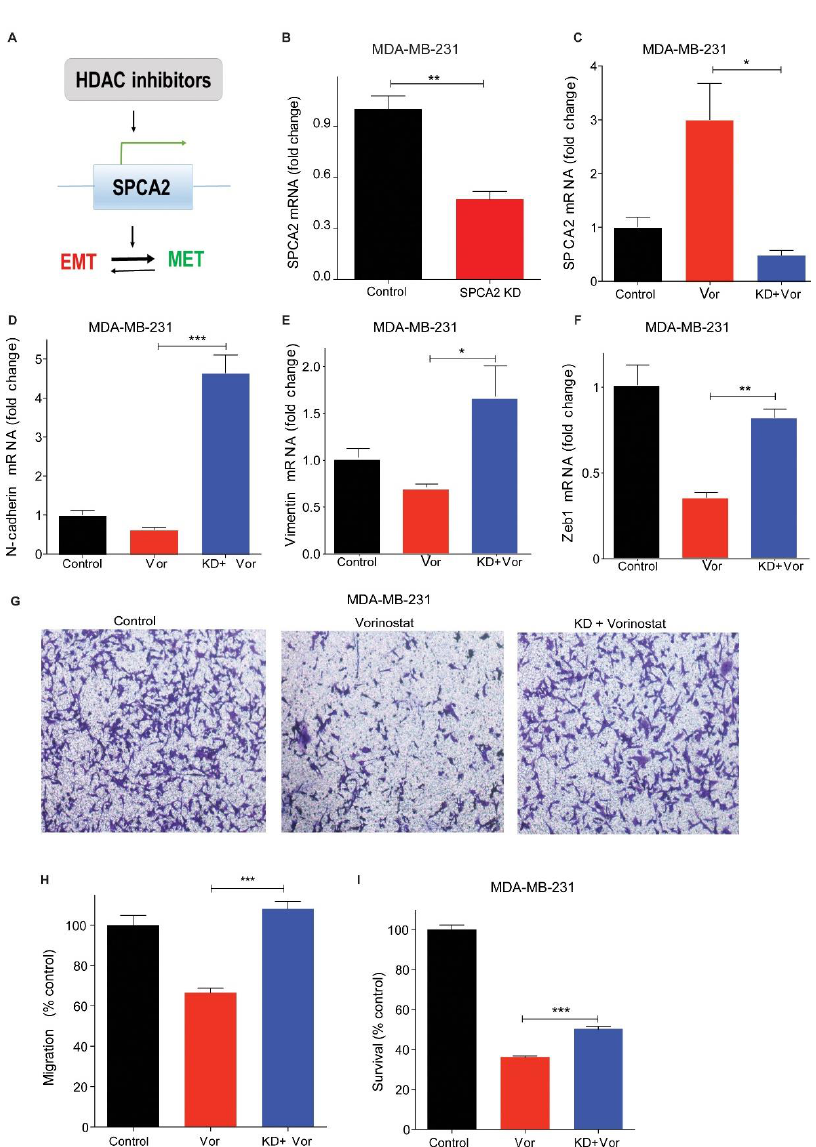
Figure 4. SPCA2 is required for HDACi-induced MET changes in TNBC cell lines. ( A ) Schematic showing that HDAC inhibitors regulate SPCA2 expression, which in turn, promotes MET. ( B ) SPCA2 mRNA, determined by qPCR, shows efficacy of knockdown (KD) in MDA-MB-231 cells relative to scramble shRNA control, and ( C ) following treatment with vehicle (control) or vorinostat (2.5 µM) for 24 h, as indicated. ( D – F ) Expression of mesenchymal gene markers N-cadherin, vimentin and ZEB1 was determined by qPCR following treatment with vehicle (control) or vorinostat (2.5 µ M). SPCA2KD effectively reversed decrease in mesenchymal gene expression in the presence of vorinostat. n = 3. ( G ) Representative microscope images of MDA-MB-231 cells and MDA-MB-231 SPCA2 KD treated with vehicle or vorinostat (2.5 µ M) for 24 h, in Boyden chamber (10 × magnification). ( H ) Migration was quantified by ImageJ software from 3 images for each condition. ( I ) SPCA2 KD in MDA-MB-231 significantly reduced cytotoxic effect of vorinostat ( n = 6, 2.5 µ M for 80 h, MTT assay). Student t -test, *** p < 0.001, ** p < 0.01, * p < 0.05. Importantly, we show that silencing of SPCA2 prevented downregulation of mes- enchymal markers vimentin, N-cadherin, and ZEB1 by vorinostat; instead,